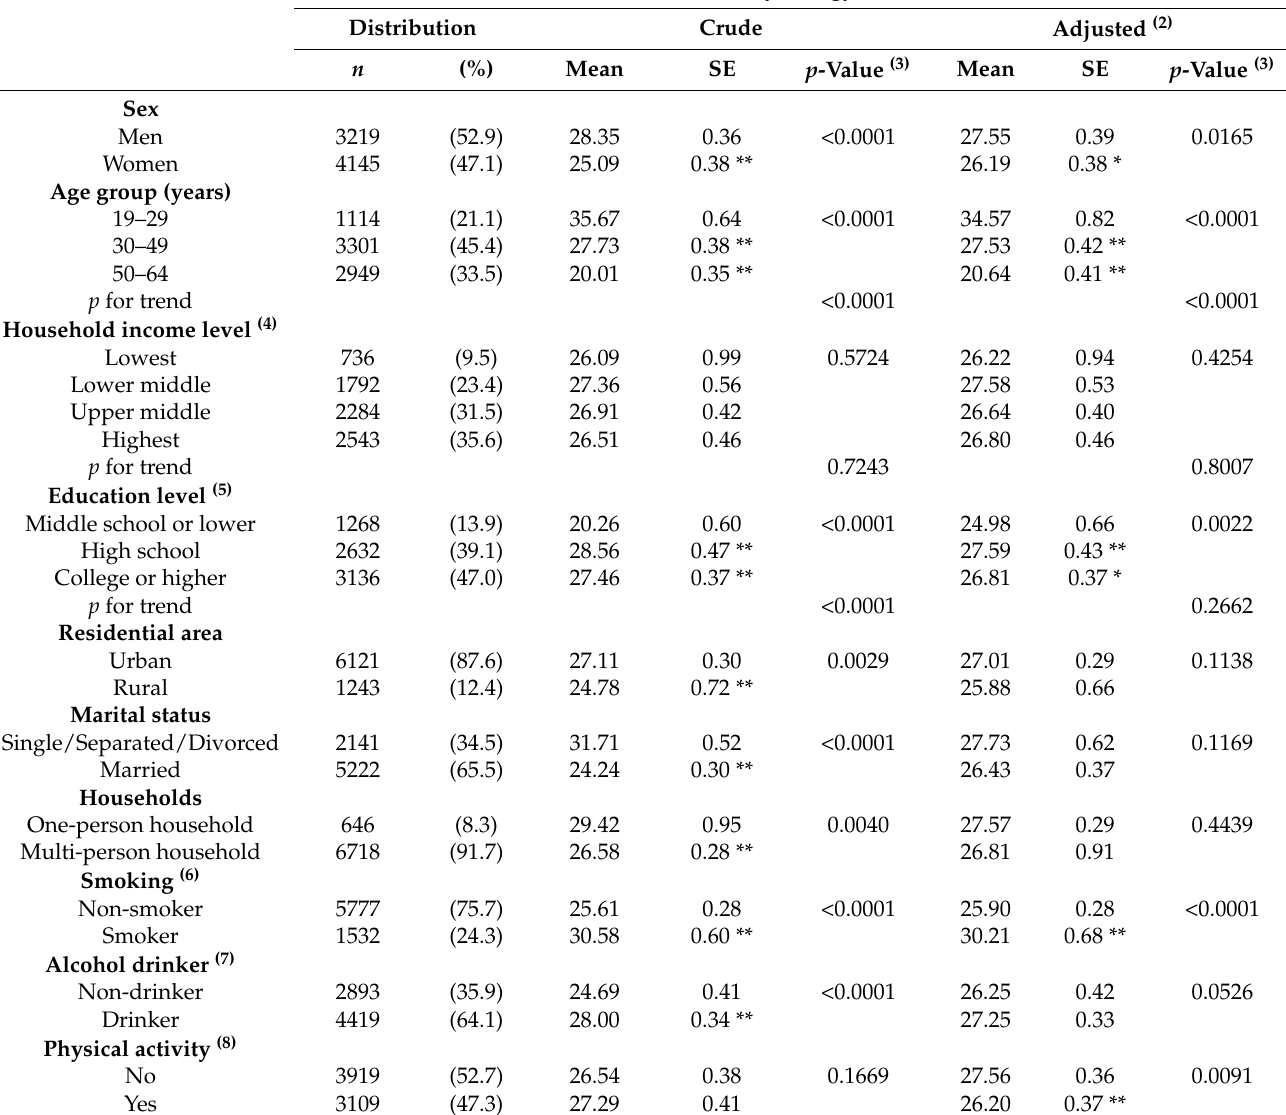
Table 2. Relative energy intake from ultra-processed foods according to the general characteristics of the participants among Korean adults (1)